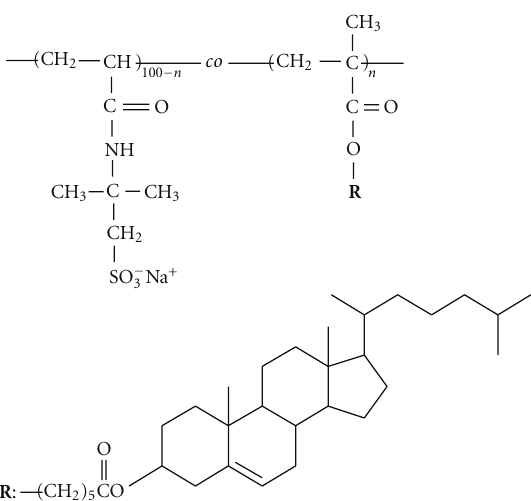
Figure 7: Chemical structure of cholesterol-bearing